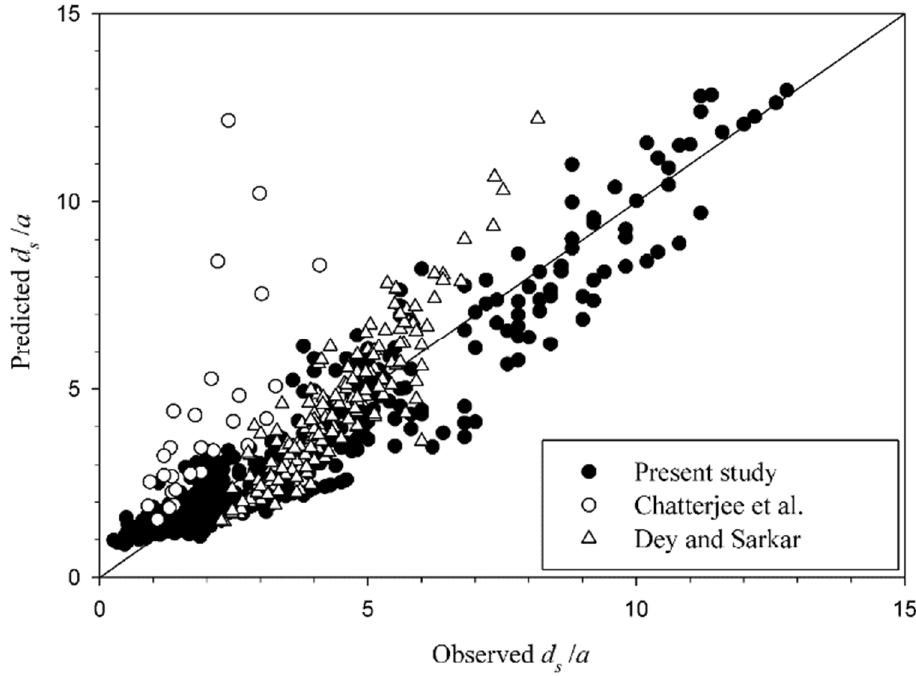
Figure 10. The maximum scour depths d s / a calculated using Equation (4) is compared with the experimental data (Chatterjee [7] and Dey and Sarkar [15]).